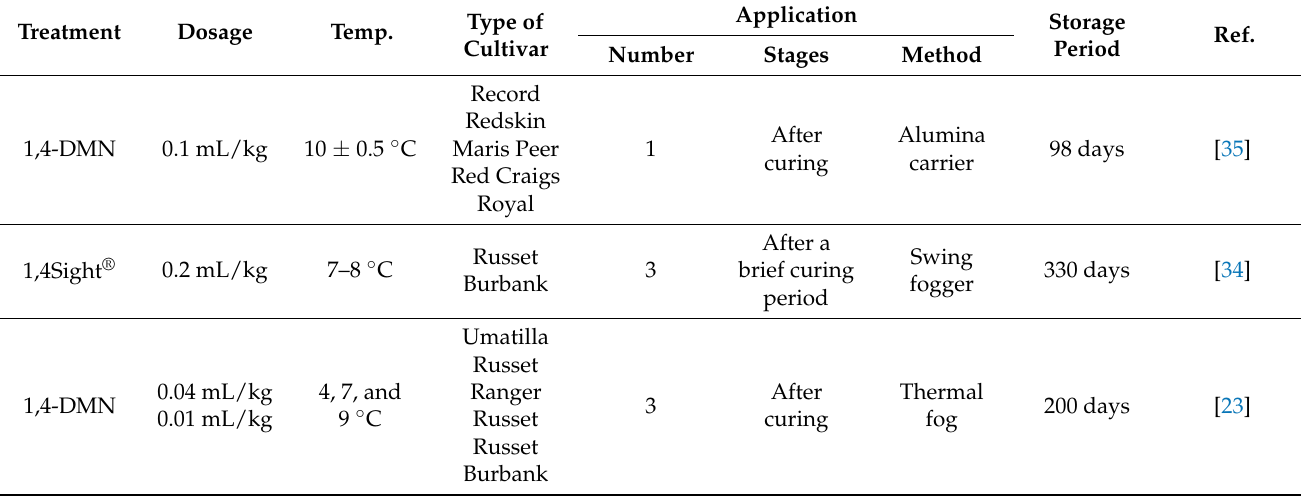
Table 2. Efficacy studies on 1,4-DMN and 1,4Sight ® as alternative sprout suppressants. Treatment